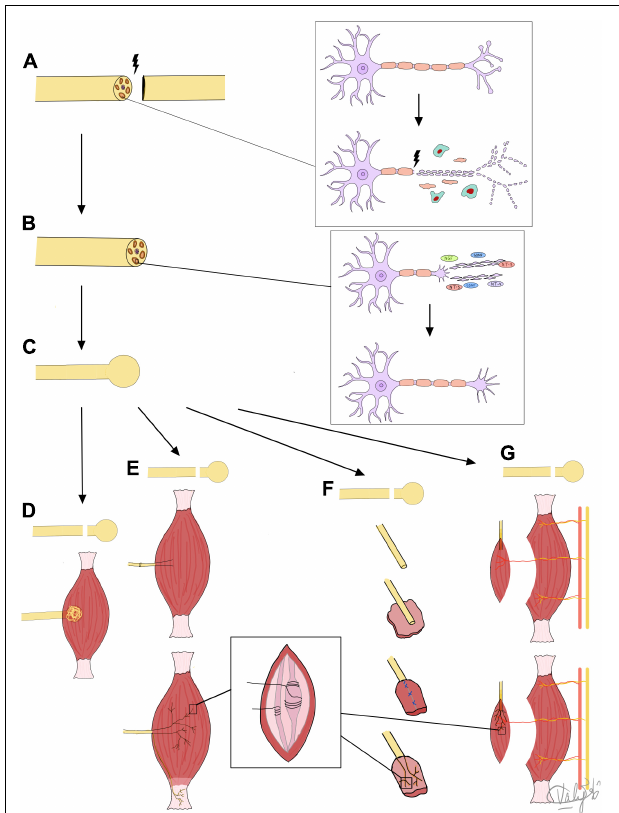
FIGURE 1 | Summary of mechanisms of nerve regeneration, neuroma formation, and target receptors for regenerating fibers. (A) Nerve injury leads to Wallerian degeneration of nerve fiber back to first node of Ranvier. (B) Nerve fiber regeneration by axolemma sprouting, and growth cone and lamellipodia/filopodia formation under influence of NTFs. (C) Formed neuroma treated by: (D) BIM: excision and nerve tuck under muscle, neuroma reforms but is protected from physical and chemical stimuli or (E) TMR: sensory nerves regenerate into coapted motor nerve stump and into muscle to reinnervate muscle spindles and Golgi tendon organs to prevent neuroma formation, or (F) RPNI or (G) VDMT: sensory nerves directly reinnervate muscle spindles in small free muscle grafts (RPNI) or vascularized, denervated portions of muscle (VDMT) to prevent neuroma formation.